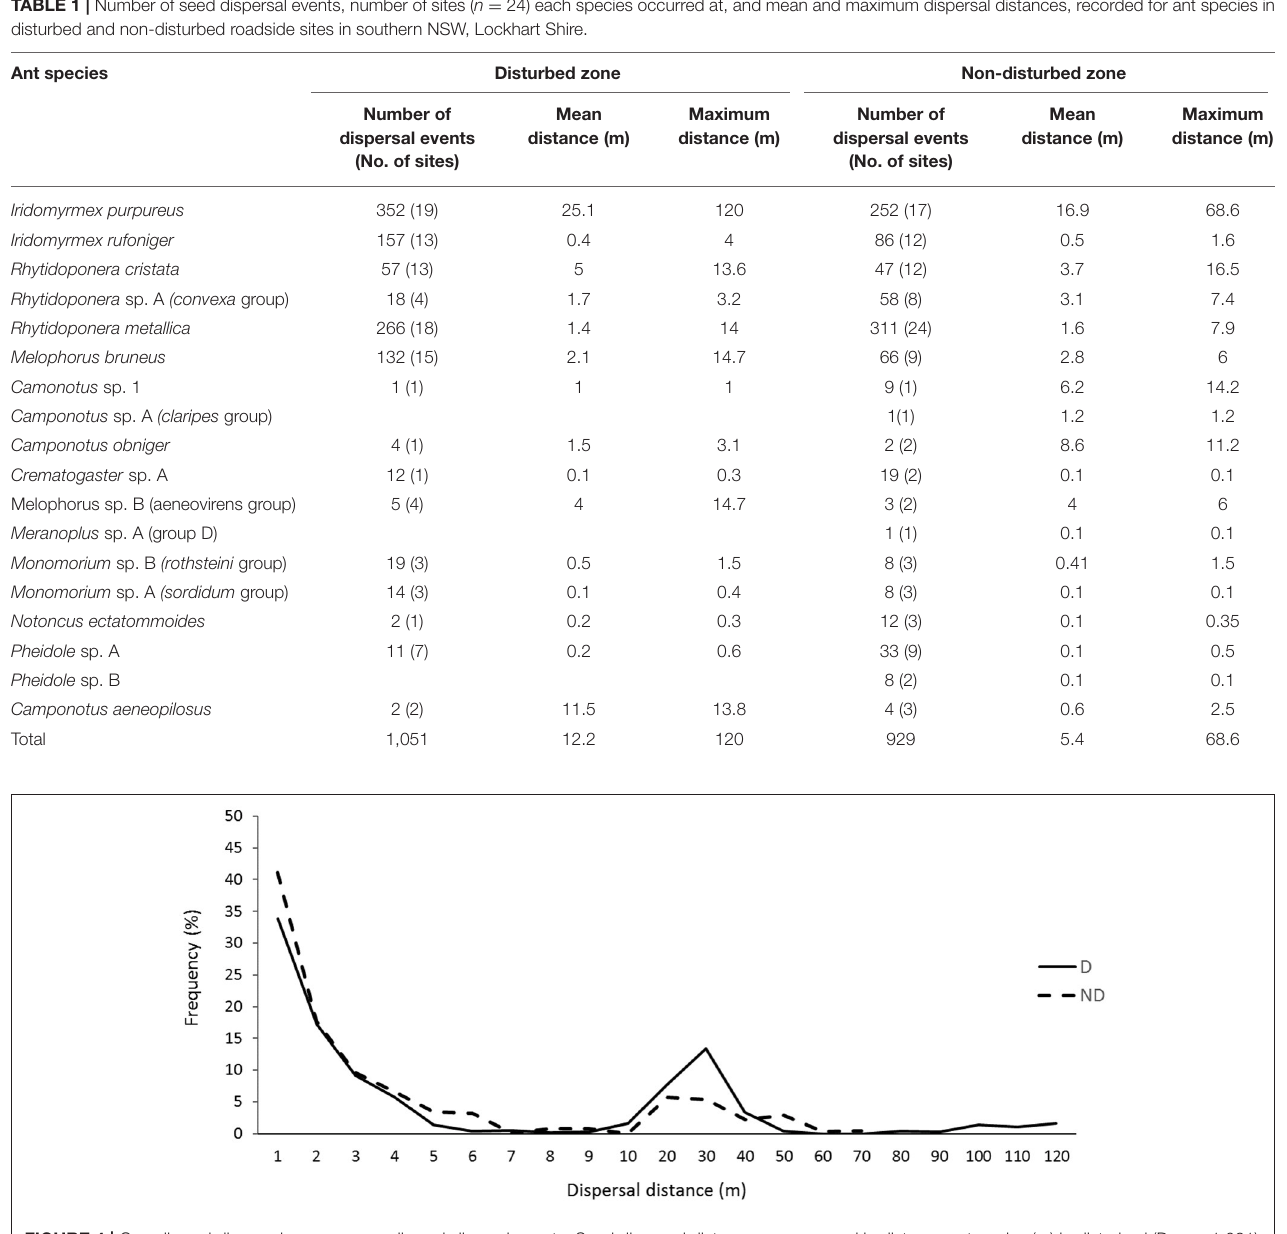
FIGURE 4 | Overall seed dispersal curve across all seed-dispersing ants. Seed dispersal distances are grouped in distance categories (m) in disturbed (D; n = 1,021) and non-disturbed (ND; n = 929) zones of roadside environments in the Lockhart Shire, southern